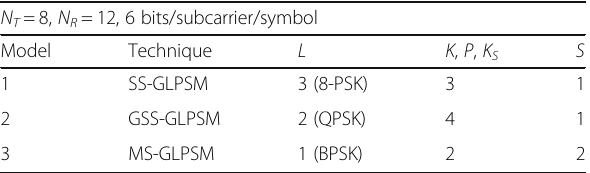
Table 2 Models parameters N T = 8, N R = 12, 6